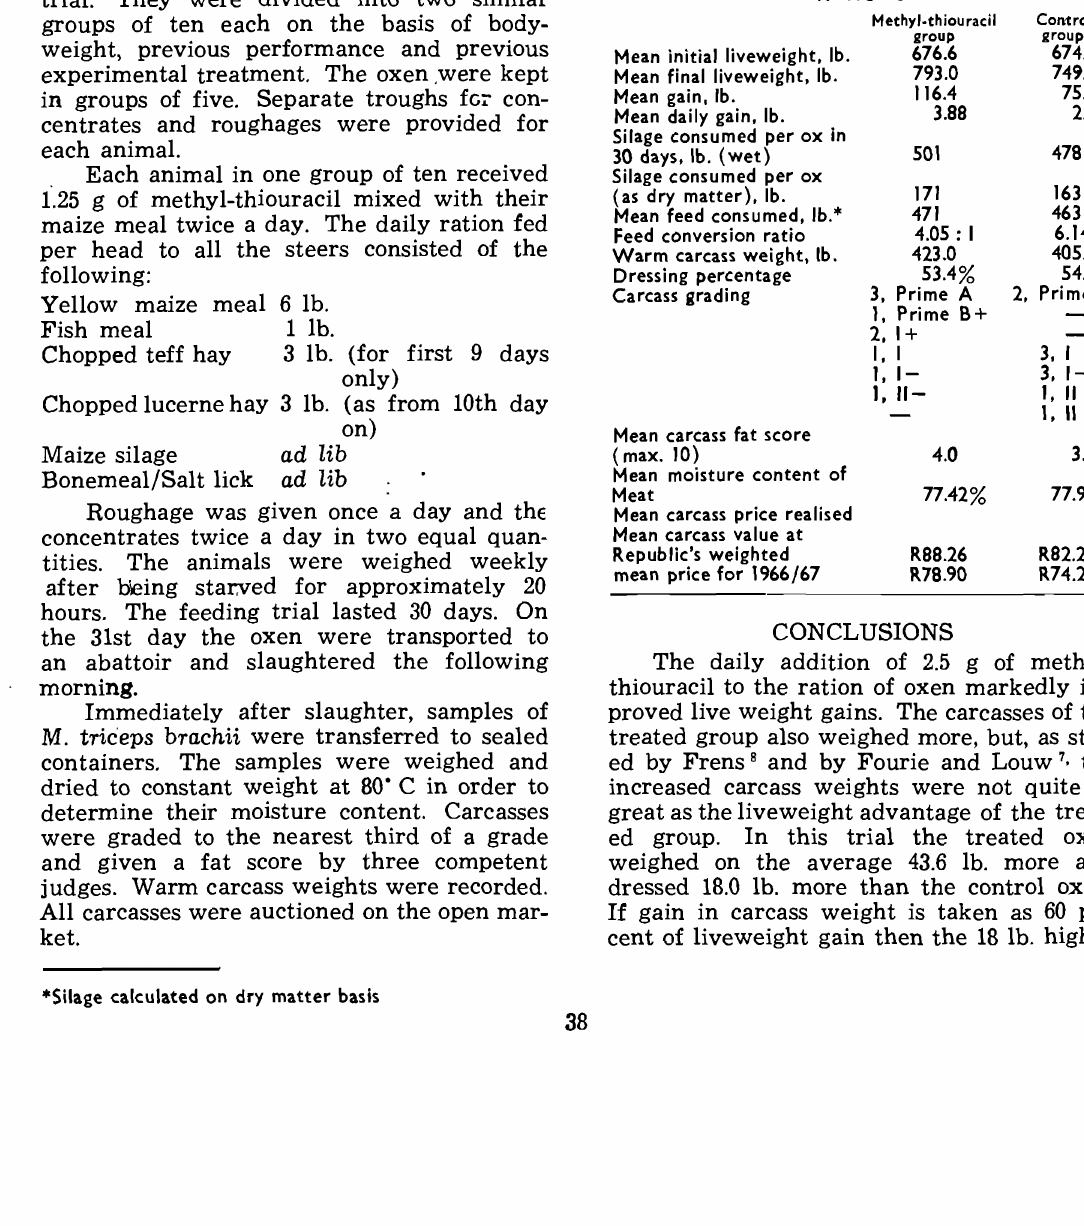
ADMINISTRATION TO STEERS ON